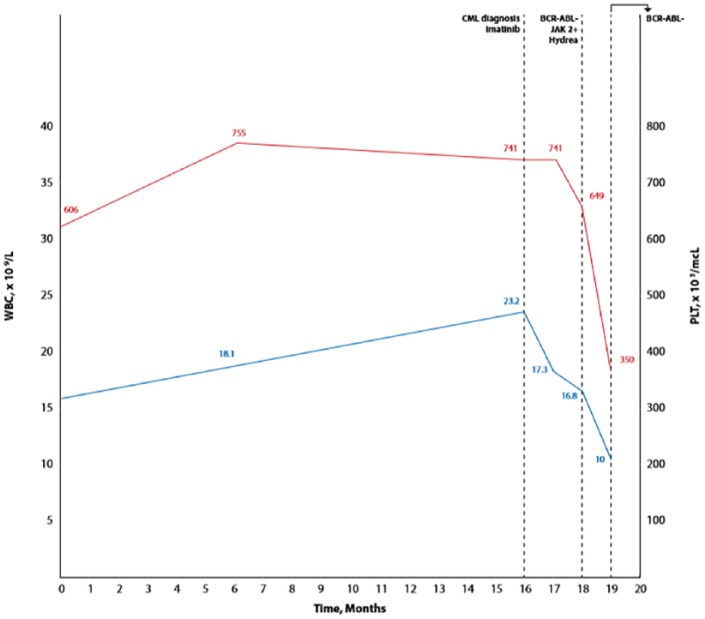
Clinical course.